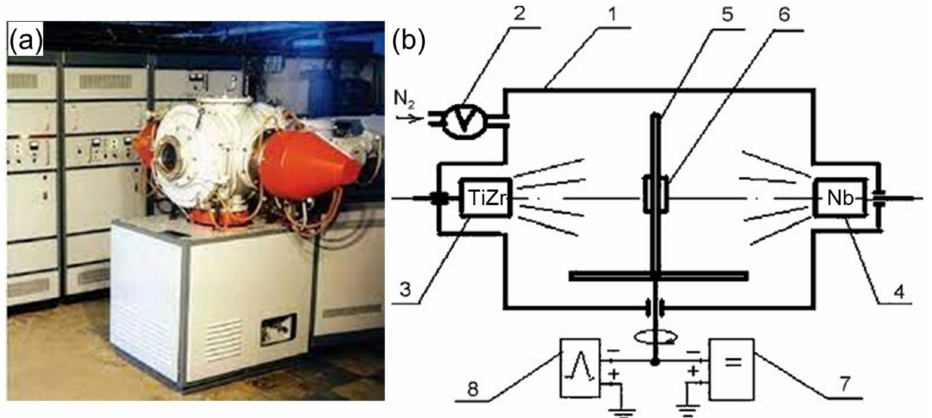
Figure 1. Vacuum arc device “Bulat-6” ( a ) outside view of device; ( b ) schematic representation of deposition system: 1—acuum chamber; 2—automatic system of nitrogen pressure control; 3,4—TiZr, Nb evaporators; 5—substrate holder; 6—substrate; 7—DC voltage source; 8—high-voltage pulse